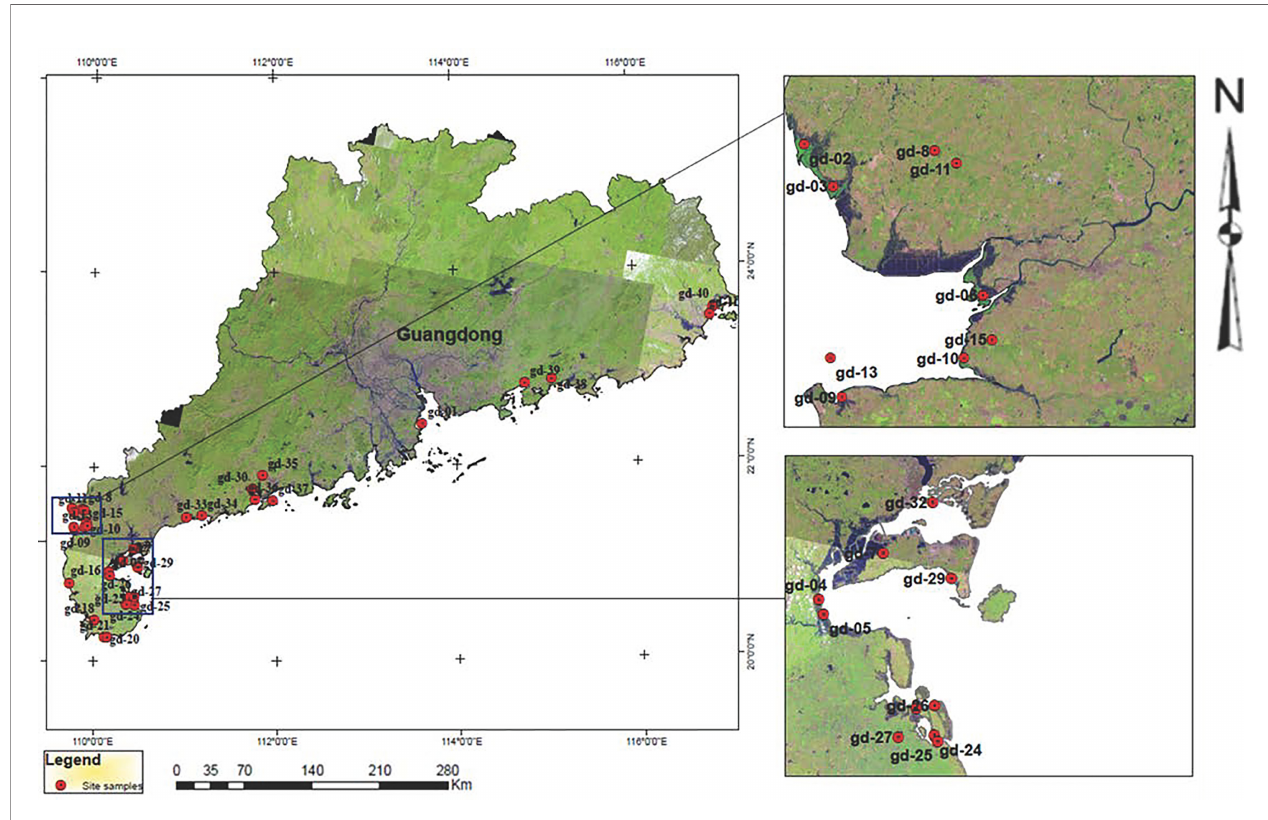
FIGURE 1 | Study area and sampling stations identi fi ed by the red dots on the